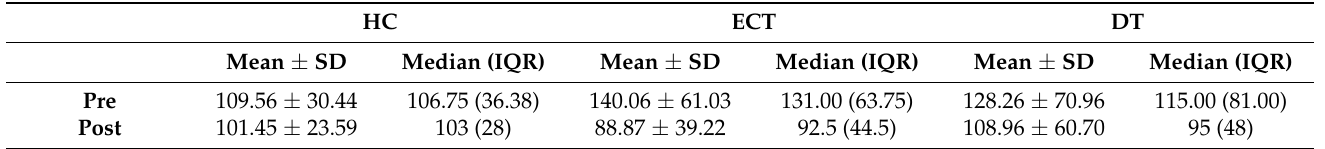
Table 3. Descriptive statistics for results from the Group by Session ANOVA conducted on the conflict effect estimated on response time (ms).